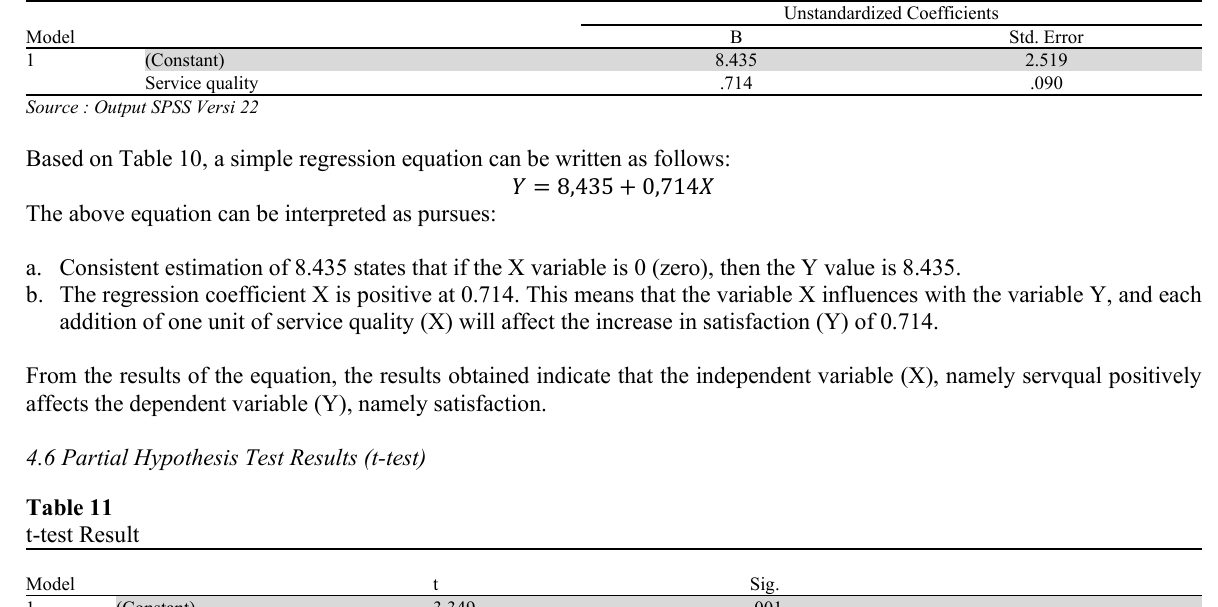
Simple Regression Analysis